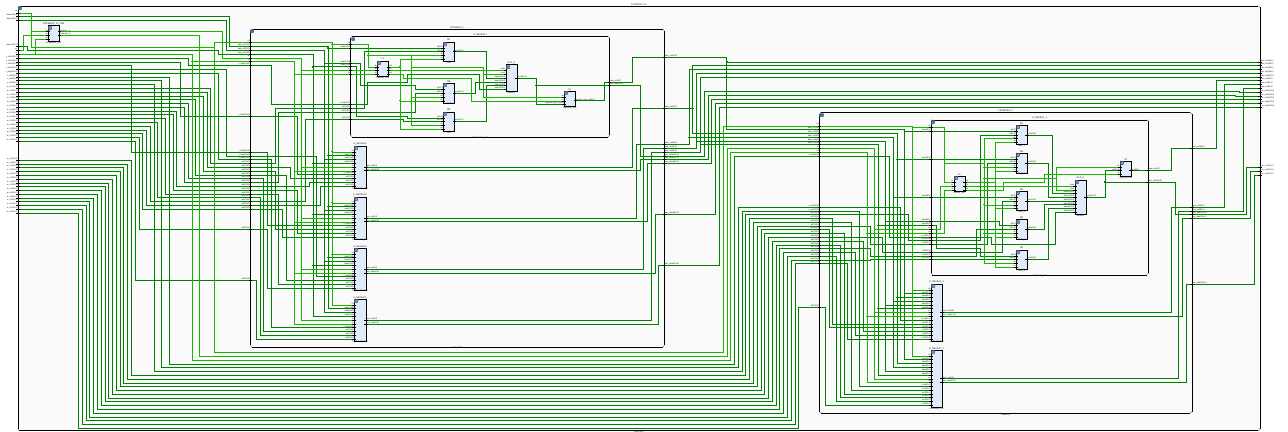
Figure 7. RTL view of the forward propagation module of a BP neural network.